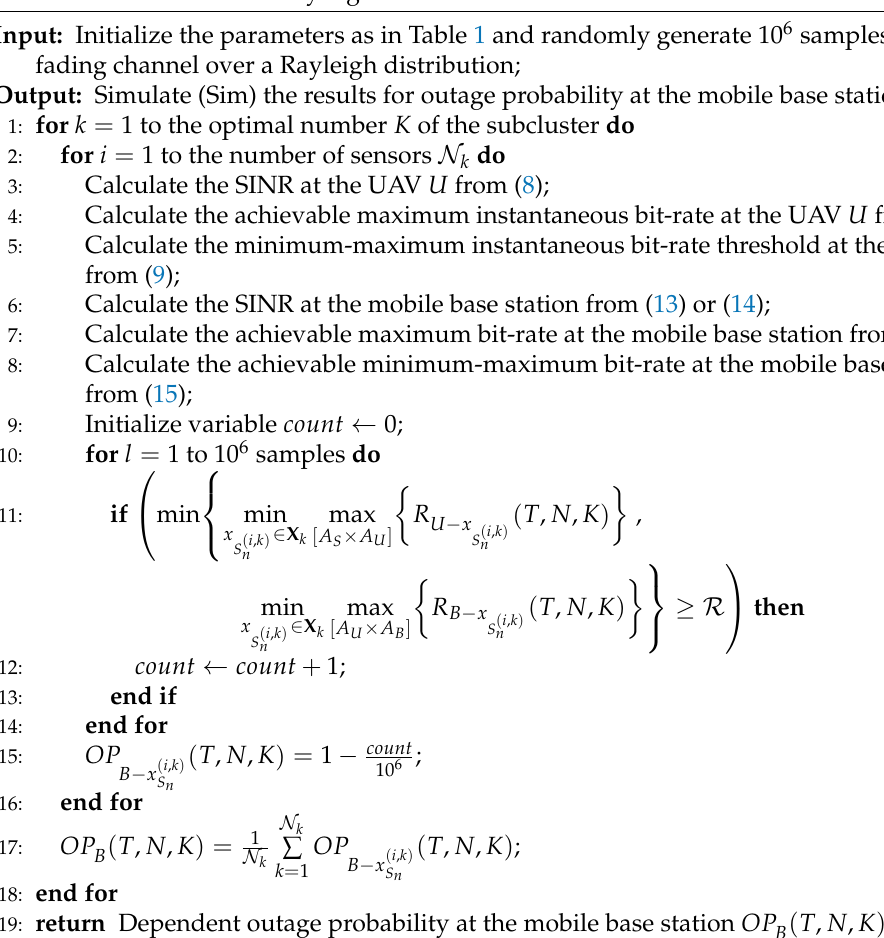
Algorithm 3 Calculate the outage probability at the mobile base station from (18) for transmission block t over Rayleigh